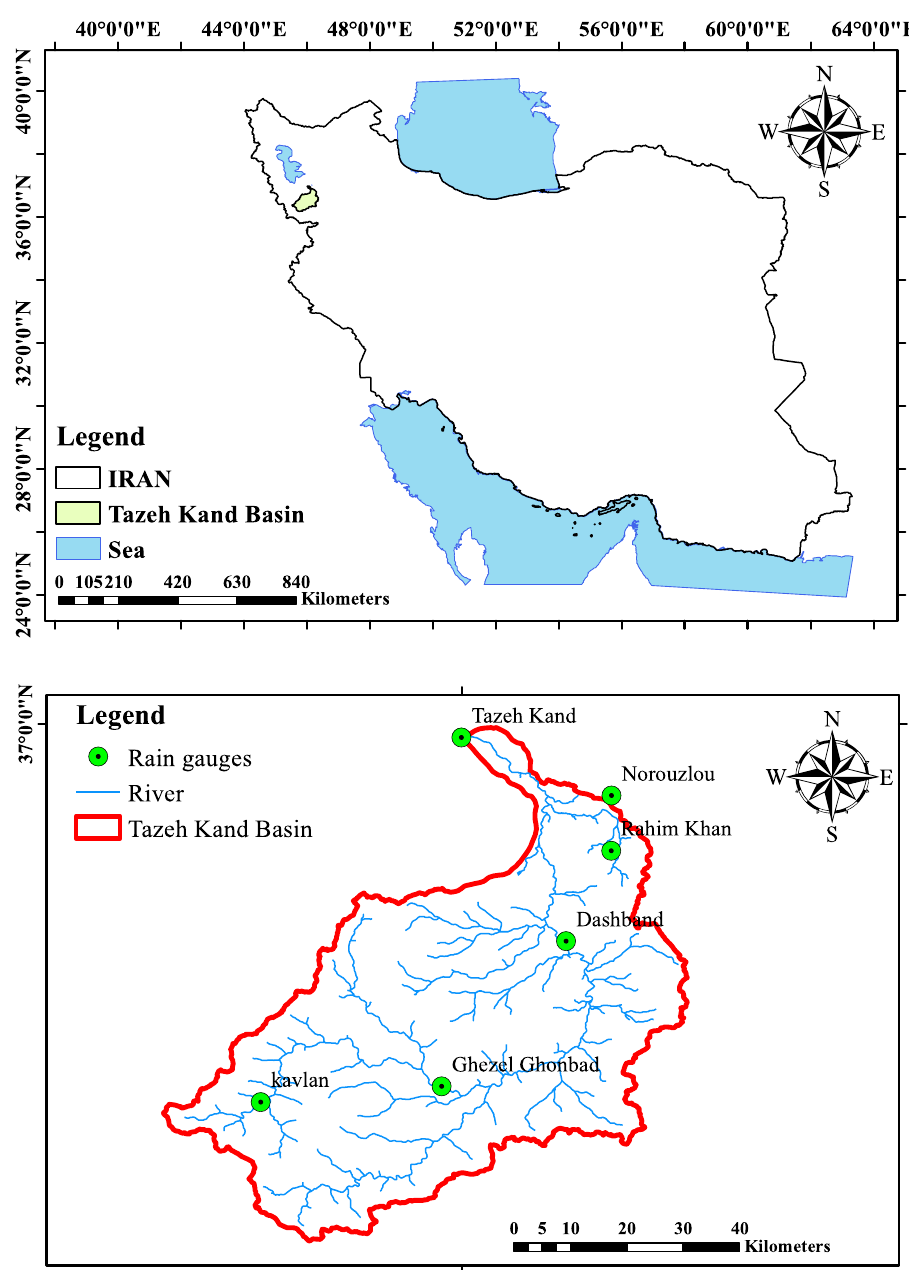
Fig. 1 The geographical loca- tion of Tazehkand sub-basin, Northwestern